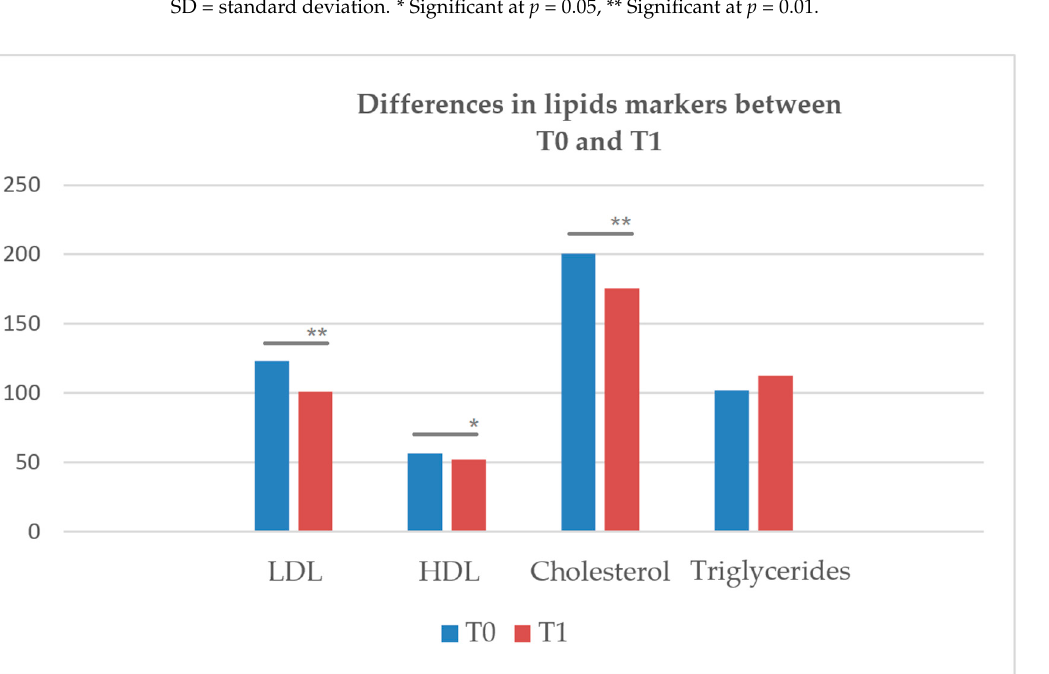
Figure 2. Graphical presentation between lipid markers in baseline (T0) vs. 2 weeks (T1). * Significant at p = 0.05, ** Significant at p =